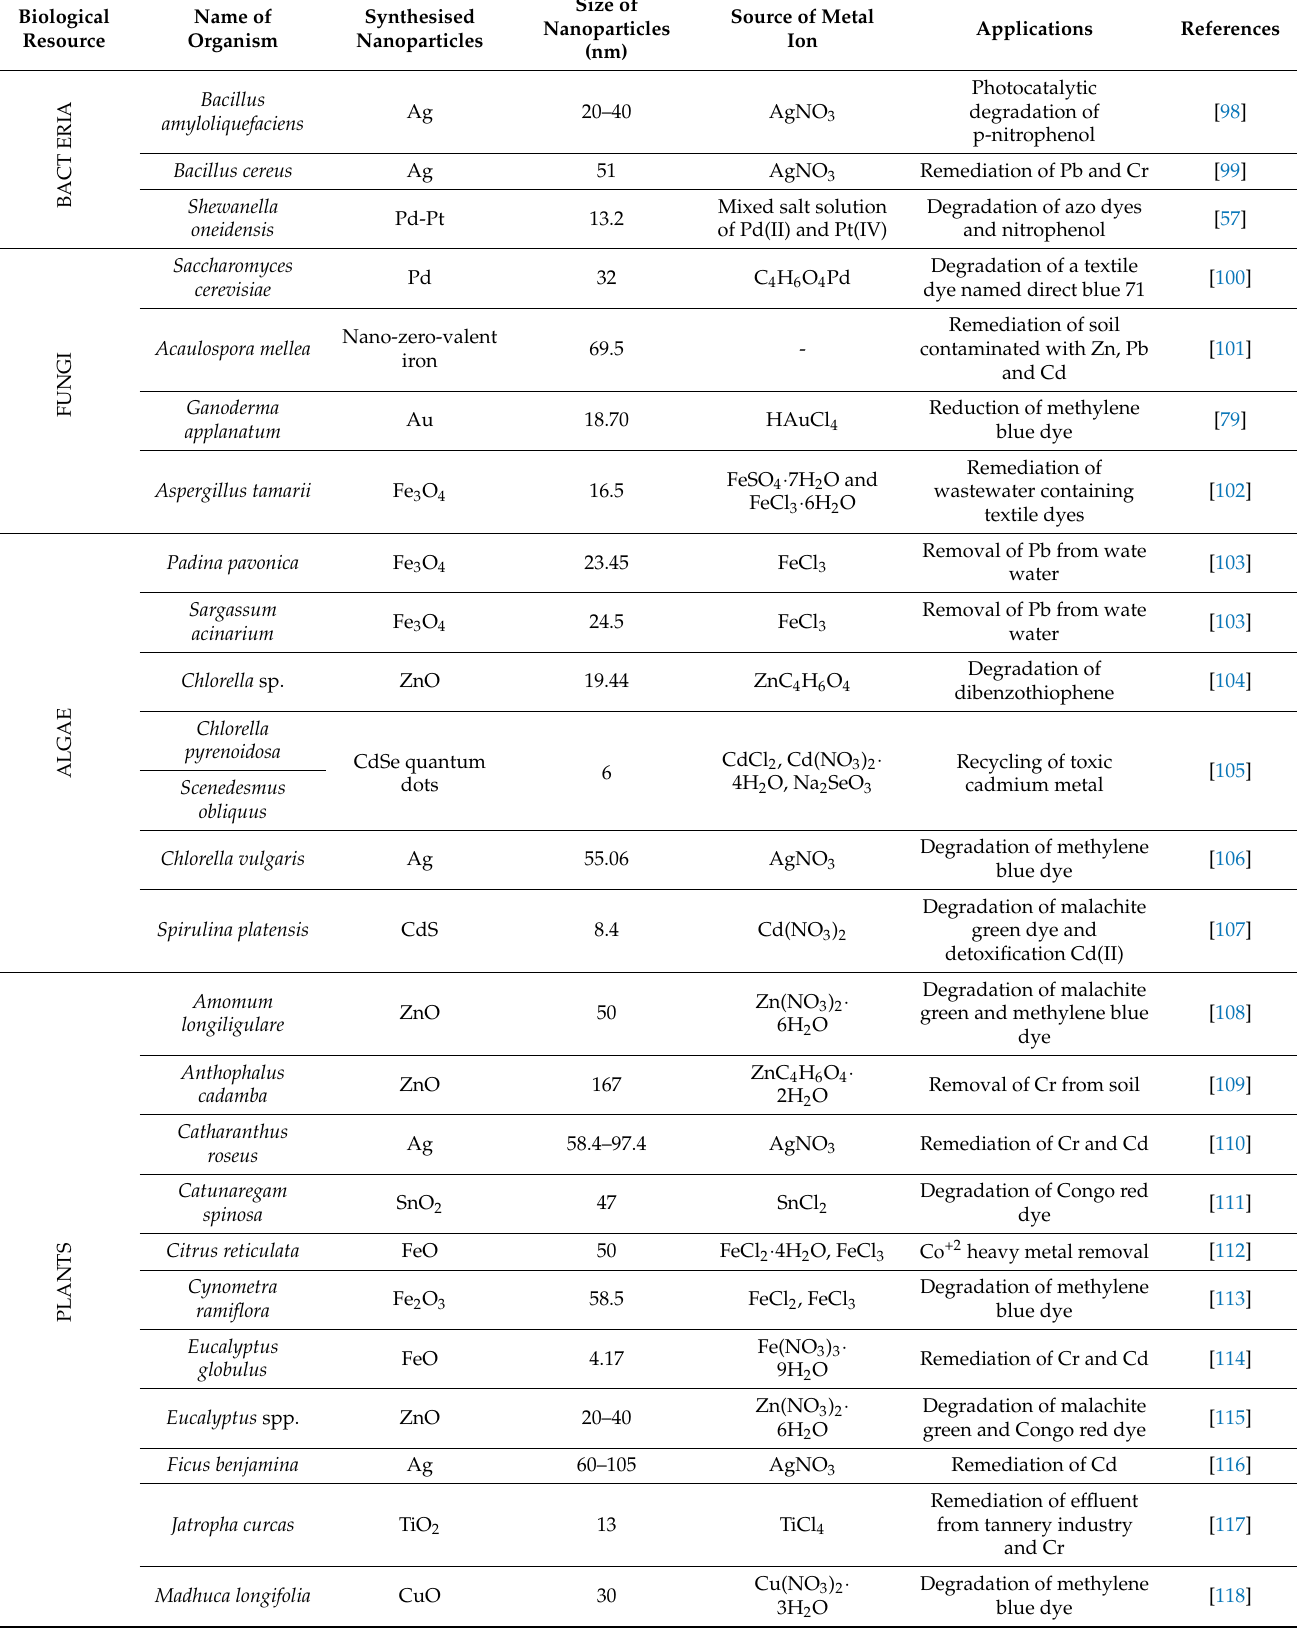
Table 2. Several biologically derived nanoparticles in environmental